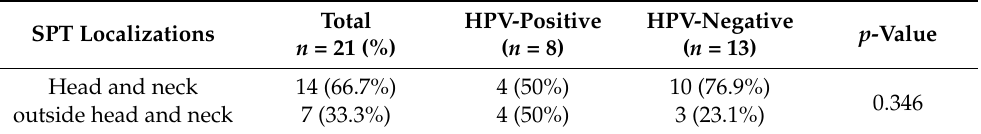
Table 4. Number of SPT in and outside the head and neck area in HPV-positive and HPV-negative patients. The p -value compares HPV-positive and HPV-negative patients regarding SPT localization in the head and neck area. The p -value was calculated using Fisher’s exact test.